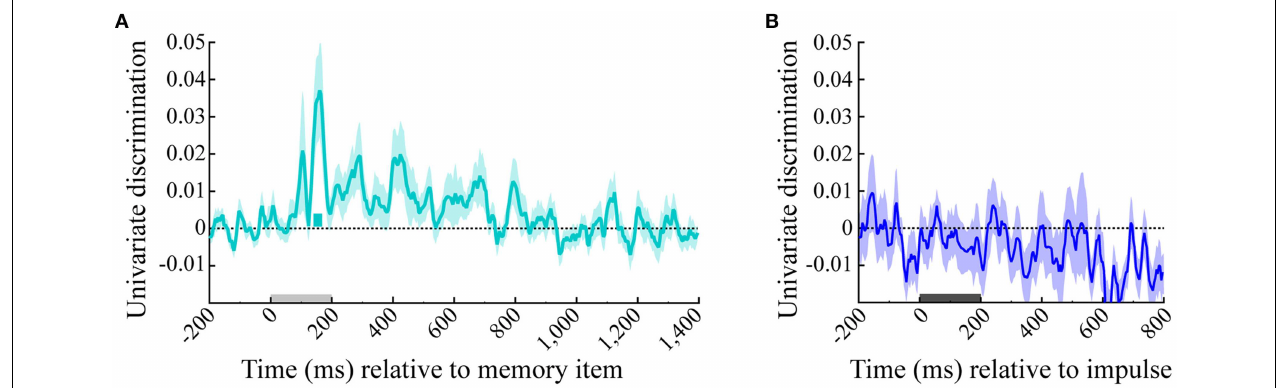
FIGURE 8 | Univariate discrimination of the memory item. The cyan and blue lines show the univariate discrimination of the memory item of the (A) memory item and (B) impulse epoch, respectively. The cyan bar indicates the significantly positive discrimination cluster of the memory item epoch. Light-gray and dark-gray bars represent memory item and impulse presentation, respectively. Error bars are standard deviations of the permuted